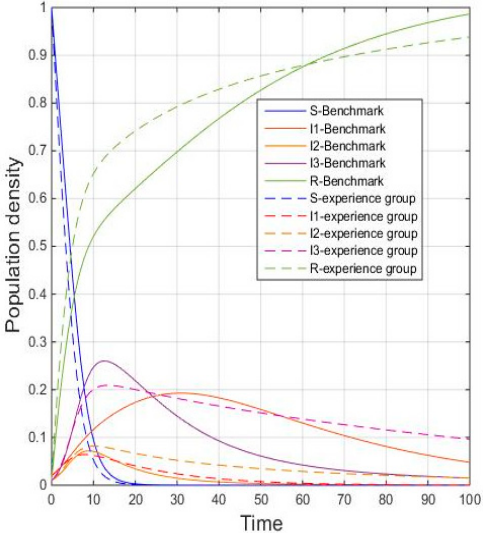
Figure 10. Results of enhanced comprehensive interference governance.